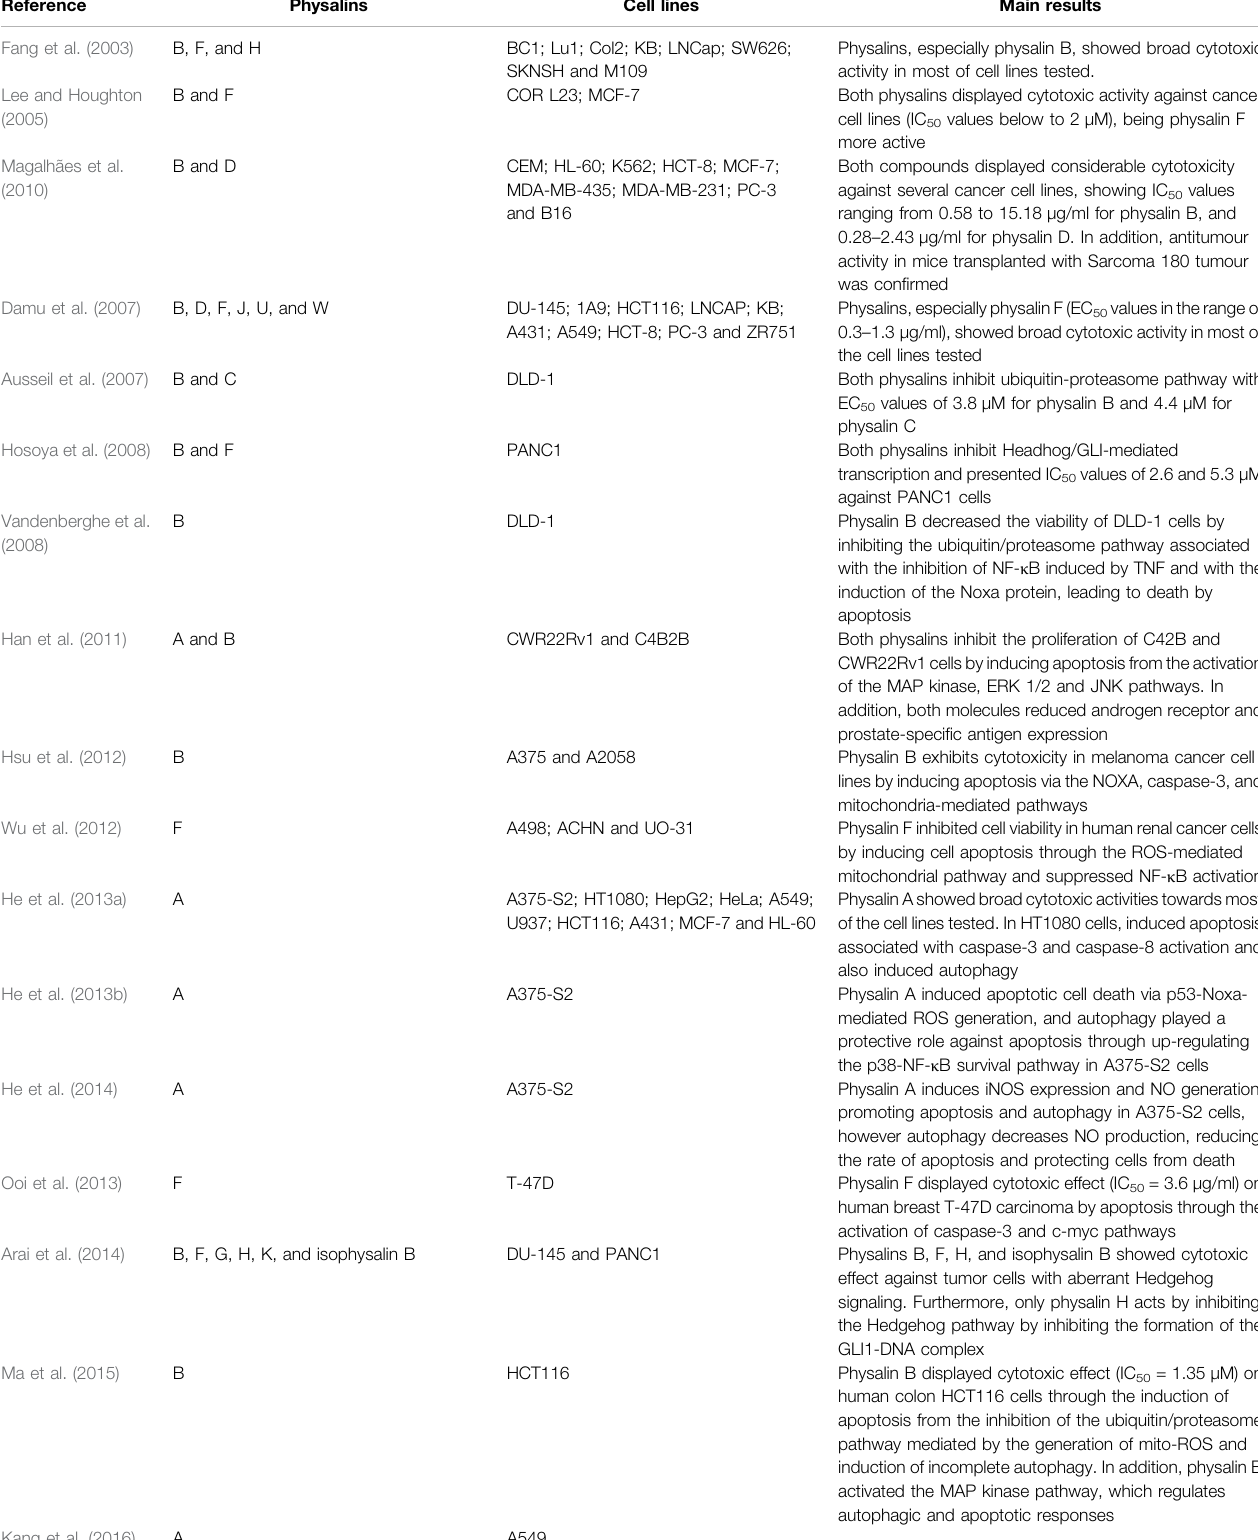
TABLE 4 | Cytotoxic activity of